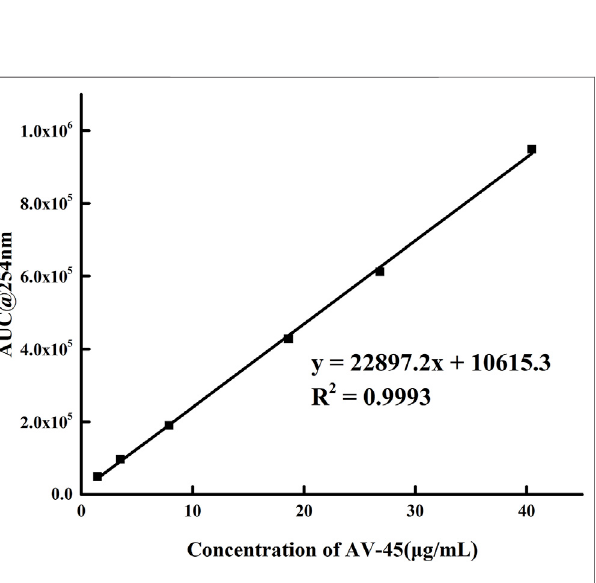
FIGURE 4 | Working curve of AV-45 series concentration